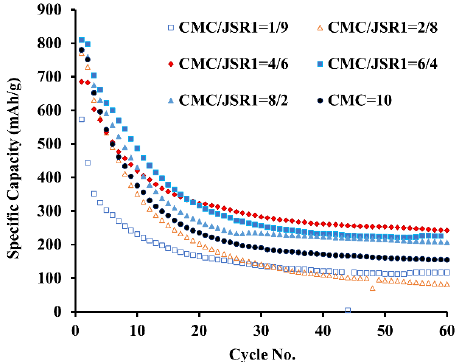
Figure 1. Cycling performance of anodes made of different binder ratios of CMC and SBR (JSR1) under C/10. Electrode composition: CGP-G8/Si/C45/binder = 73/15/2/10 (wt.%).